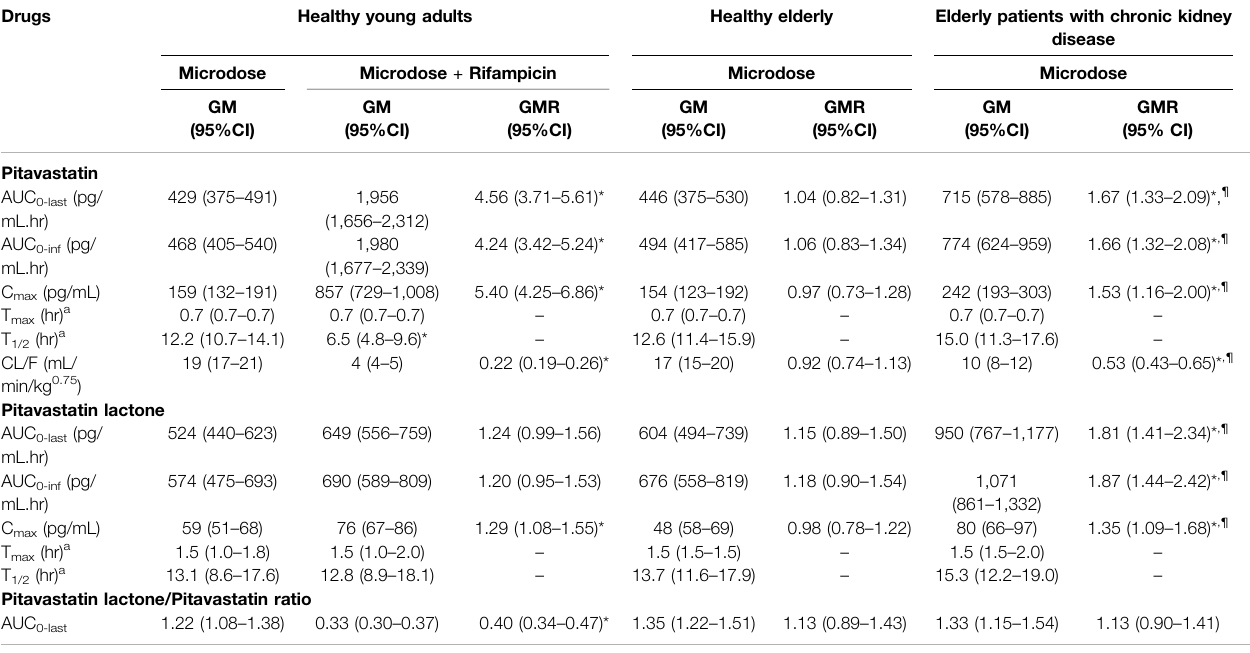
TABLE 3 | Pharmacokinetic parameters of pitavastatin and pitavastatin